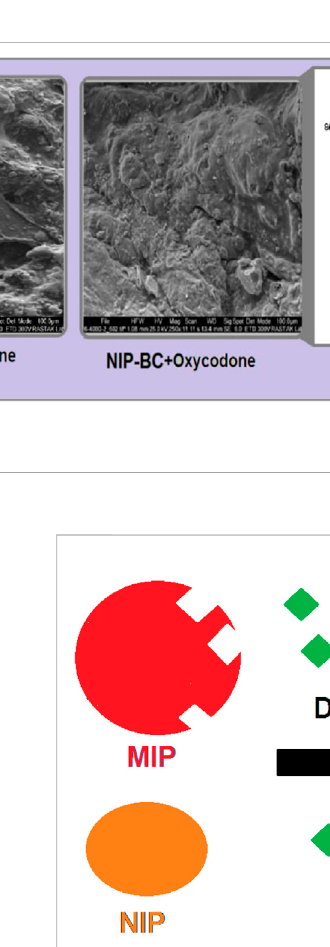
FIGURE 1 The absorption of the drug molecules by MIP in comparison with its adsorption process by